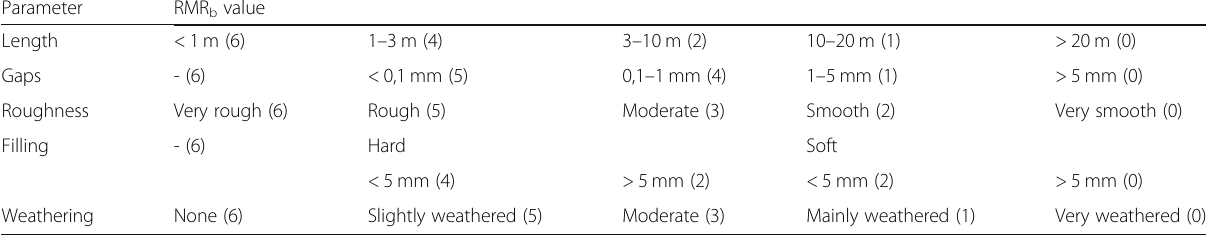
Table 4 The condition of discontinuous plane classification (Bieniawski 1989)